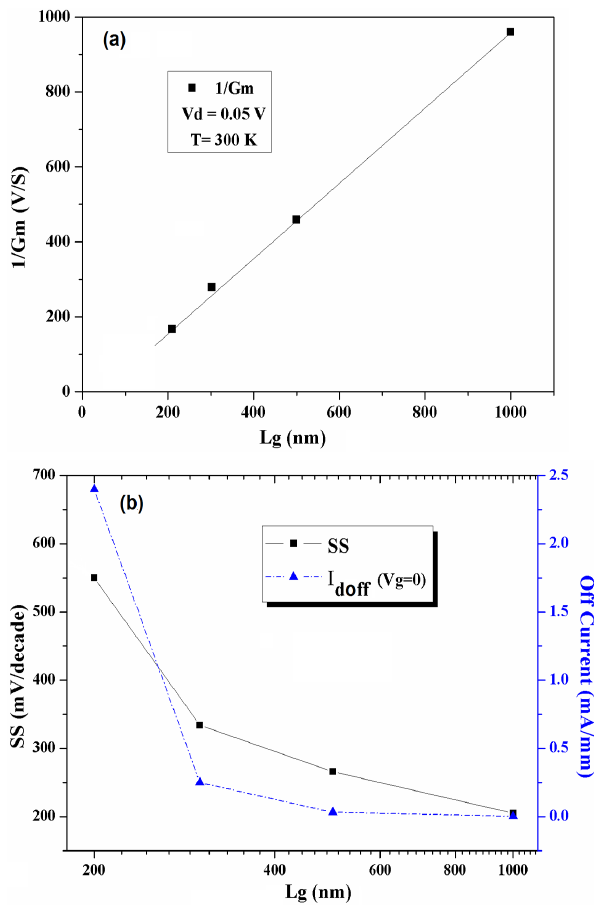
Figure 6. Variationof1/G m with gatelengthfor D L extraction(a), Subthreshold swing and I doff (b) for self-aligned In 0.53 Ga 0.47 As MOSFETs.